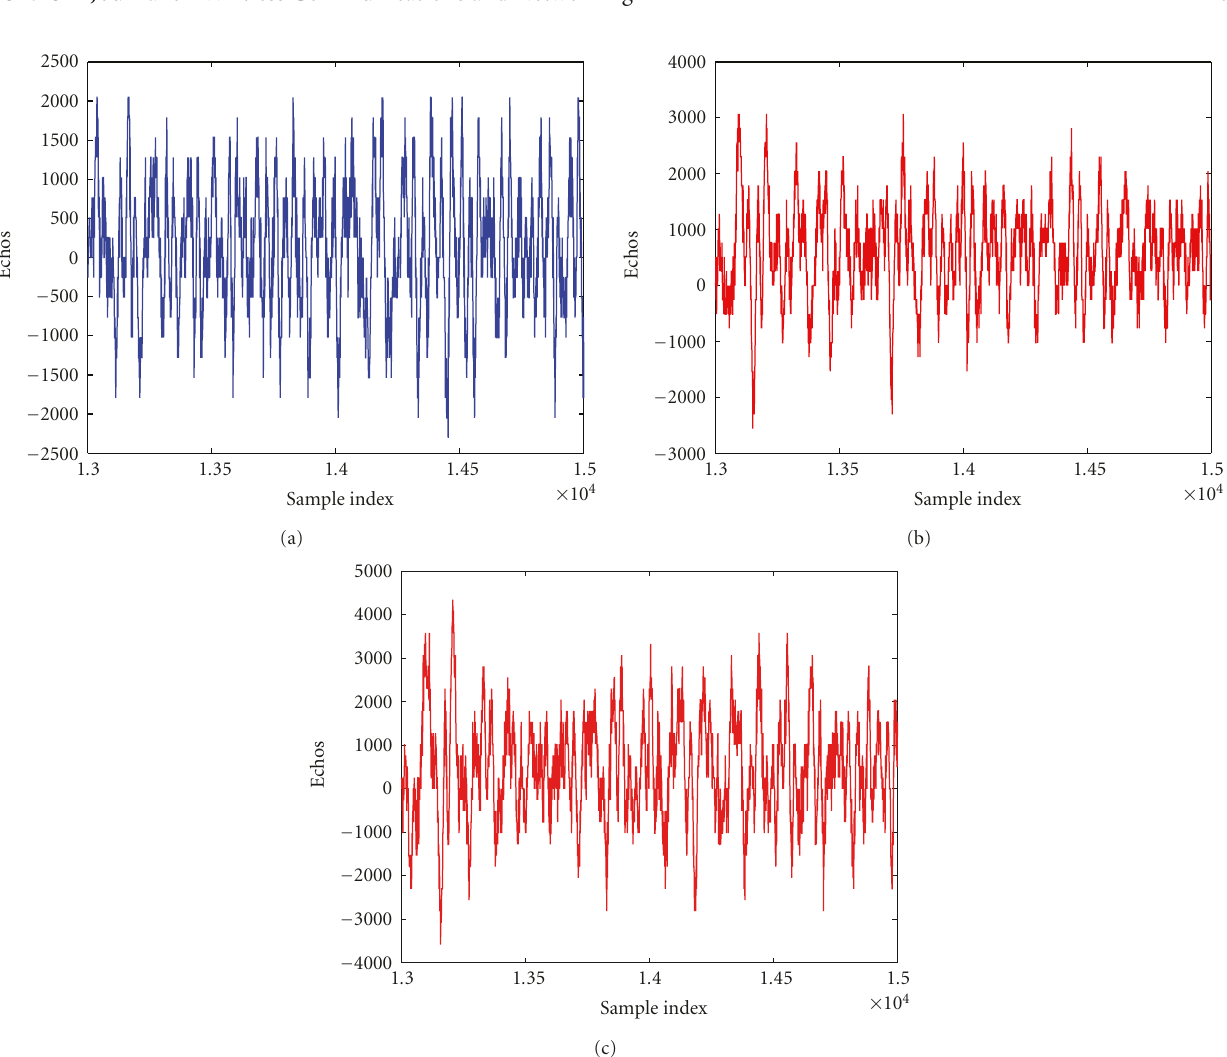
Figure 5: Measurement with 35 pulses average. (a) Expanded view of traces (no target) from sample 13001 to 15000. (b) Expanded view of traces (with target) from samples 13001 to 15000. (c) The di ff erences between (a) and (b).